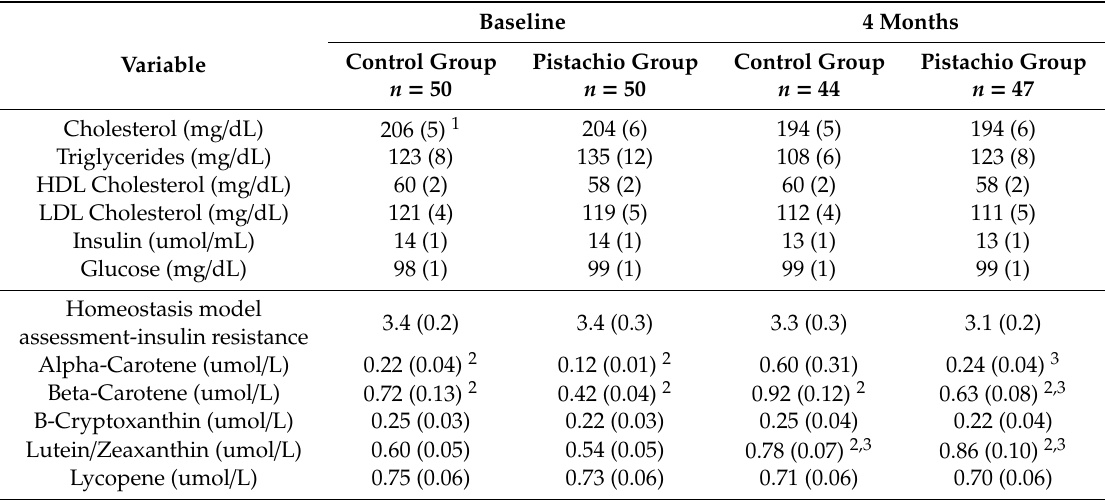
Table 4. Biological measurements of study participants in the weight loss